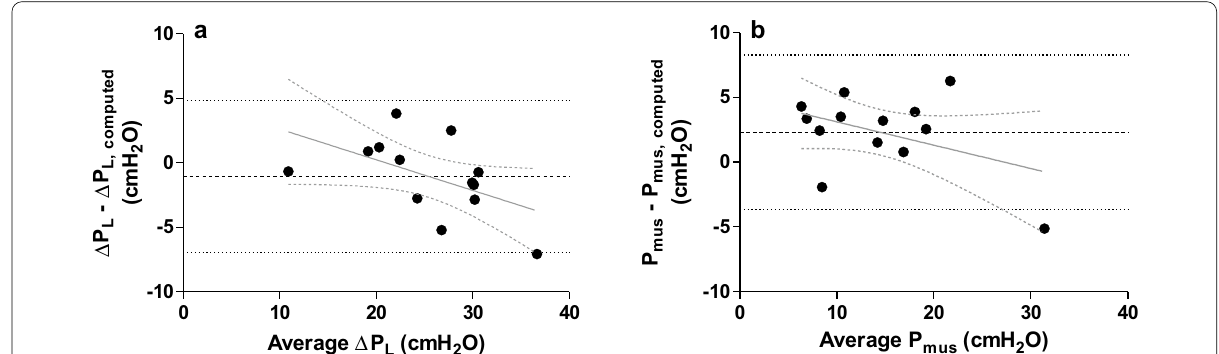
Fig. 2 Bland–Altman plots with regression lines in which measured and computed dynamic transpulmonary driving pressure (∆ P L ) ( a ) and respiratory muscle pressure ( P mus ) ( b ) are compared. Computed ∆P L overestimates measured ∆ P L ( a ) ( agreement), while computed P mus underestimates measured P mus ( b ) (2.3 was no significant trend in differences (for ∆ P L r 2